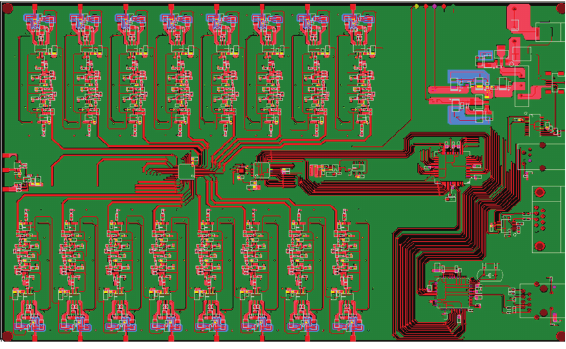
Figure 8: PCB front side configurations.